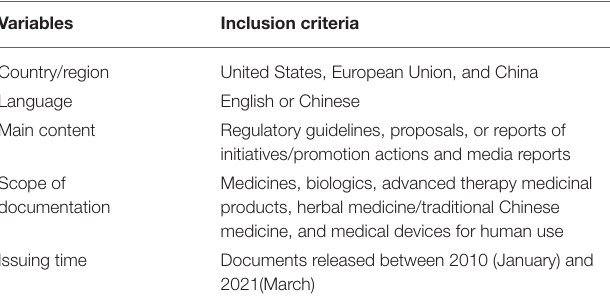
TABLE 1 | Variables and inclusion criteria in the documentary